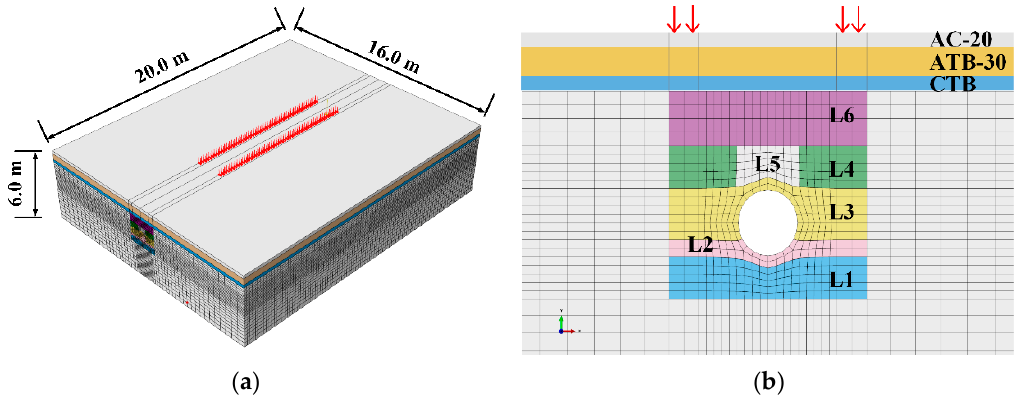
Figure 3. ( a ) Three-dimensional data of the road structure; ( b ) the layers of the road structure. Table 3. Physical properties of the pavement in numerical